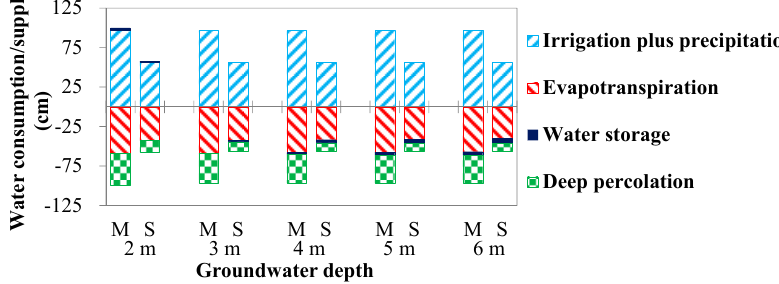
Figure 6. Soil water consumption and supply in root zone (positive means supply, negative means consumption, M means maize and S means spring wheat).